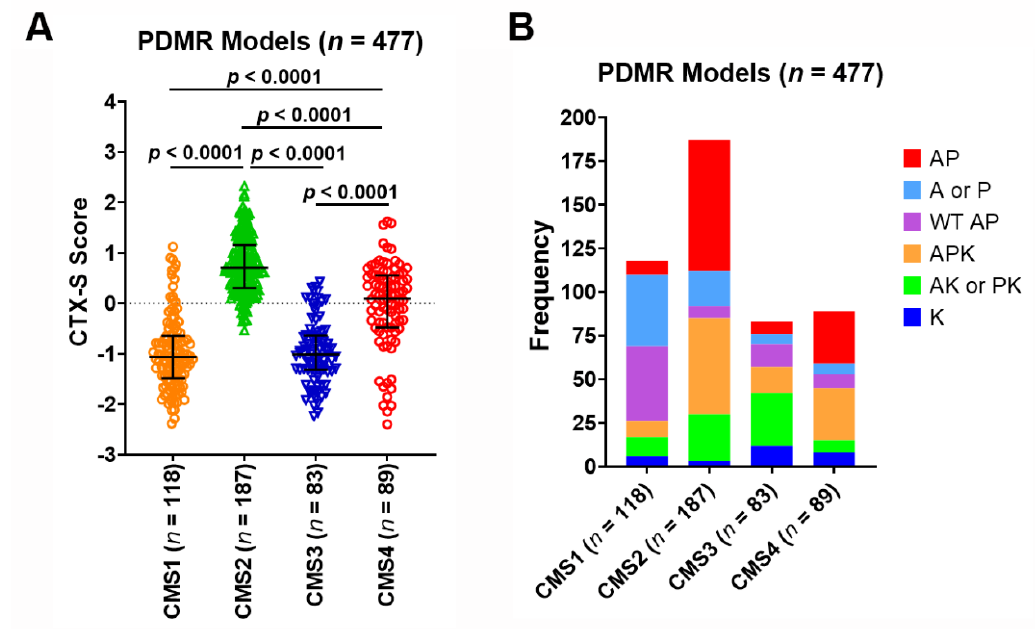
Figure 8. ( A ) Comparison of CTX-S scores among four CMS classes in PDMR CRC models. Bars represent median with interquartile range. p values are for two-tailed Welch t test. ( B ) Frequencies of six subgroups of MUT APC (A)/MUT TP53 (P)/MUT KRAS (K) across CMS1-4 classes.